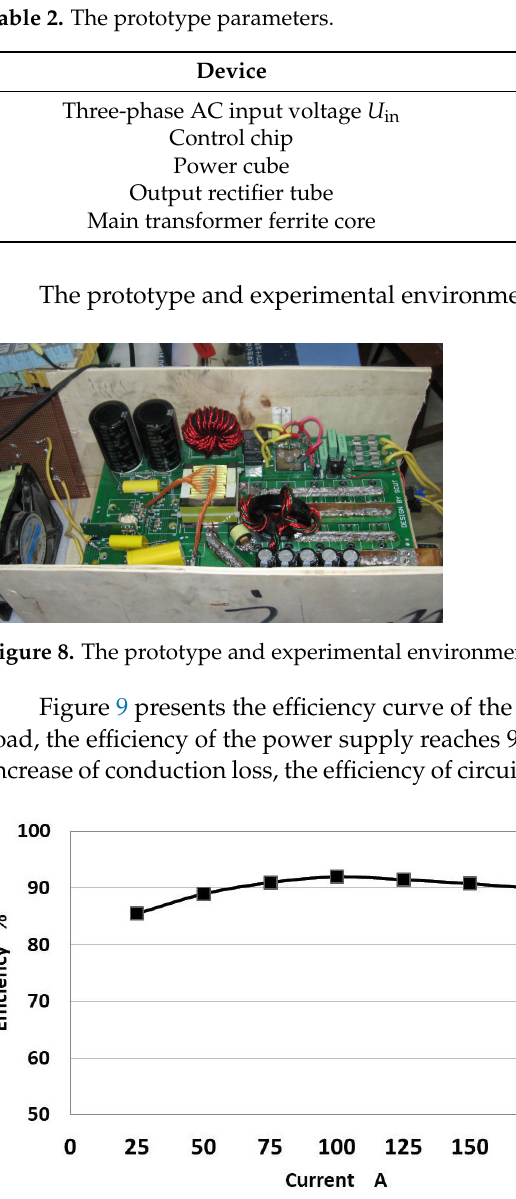
Figure 9. Efficiency